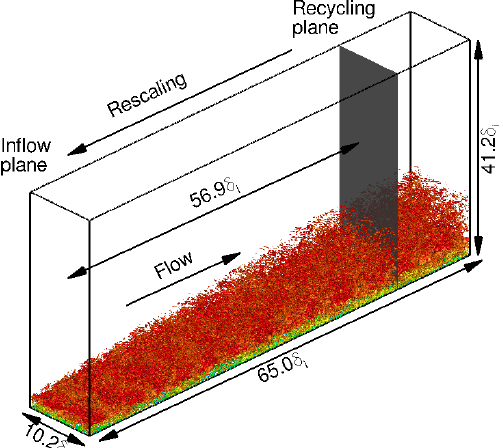
Figure 1. Computational domain and simulation setup for direct numerical simulation (DNS) of Mach 8 turbulent boundary layers. An instantaneous flowfield is shown, visualized by an isosurface of the density gradient magnitude, corresponding to | ∆ ρ | δ i / ρ ∞ = 0.98, colored by the streamwise velocity. δ i = 20.0 mm is the inflow boundary layer